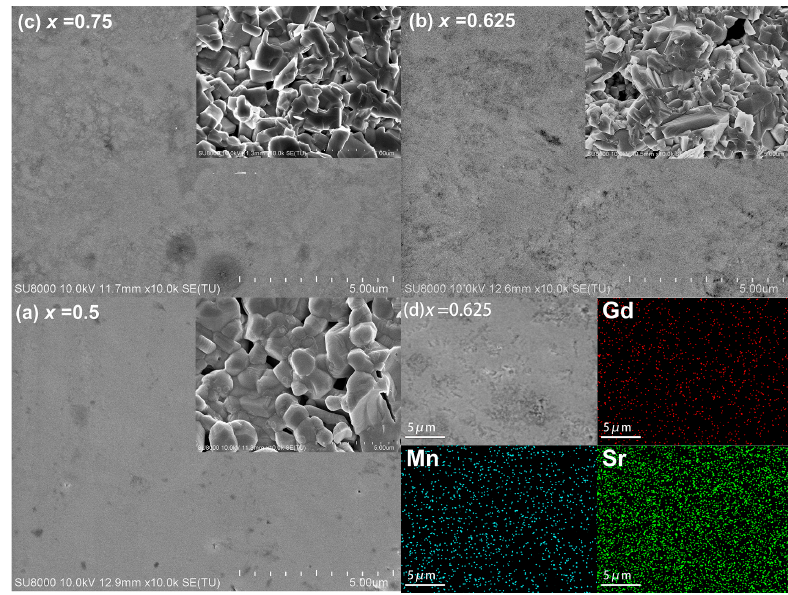
Figure 2. FE-SEM micrographs of the polished surface of sintered Gd 2 − 2 x Sr 1+2 x Mn 2 O 7 with ( a ) x = 0.5, ( b ) x = 0.625, ( c ) x = 0.75. The insets of Figure 2a–c are the fractured surface micrographs. ( d ) EDS mapping images for x = 0.625.